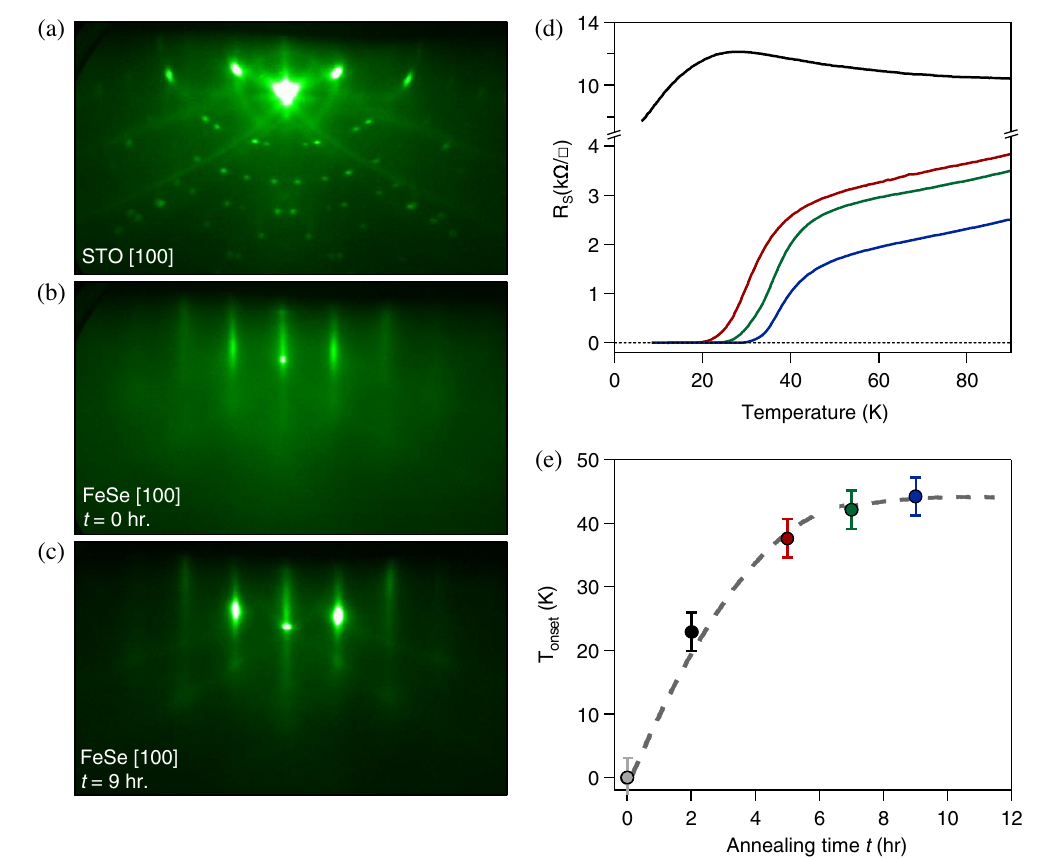
FIG. 5. RHEED images along the crystallographic [100] direction for (a) SrTiO 3 substrate prior to film deposition, (b) single-layer FeSe film immediately after growth, and (c) single-layer FeSe upon reaching maximum T c following 9 h accumulated annealing time at 450 °C. (d) In situ resistivity data as a function of accumulated annealing time t . (e) T as a function of cumulative annealing time t onset